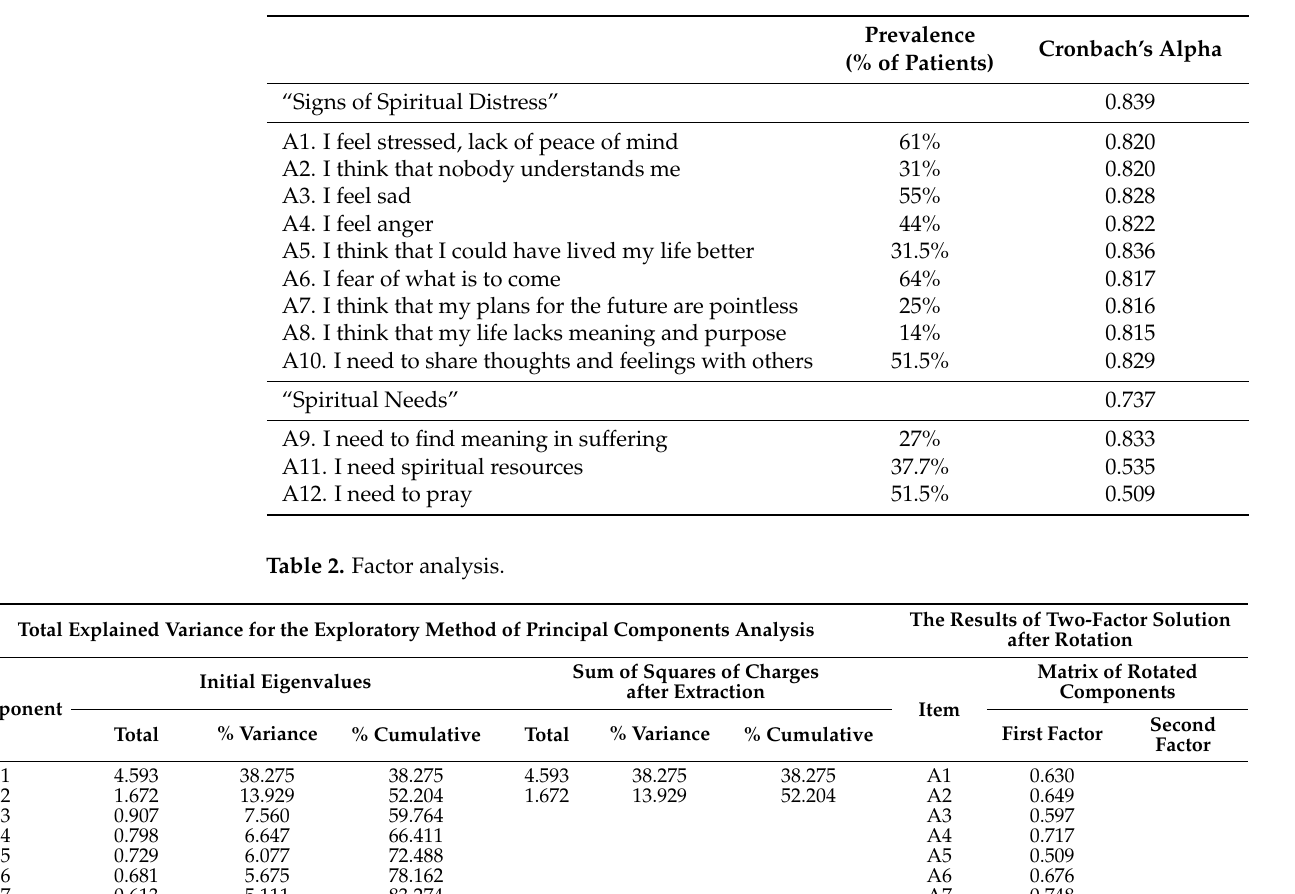
Table 1. Spiritual experiences related to illness.